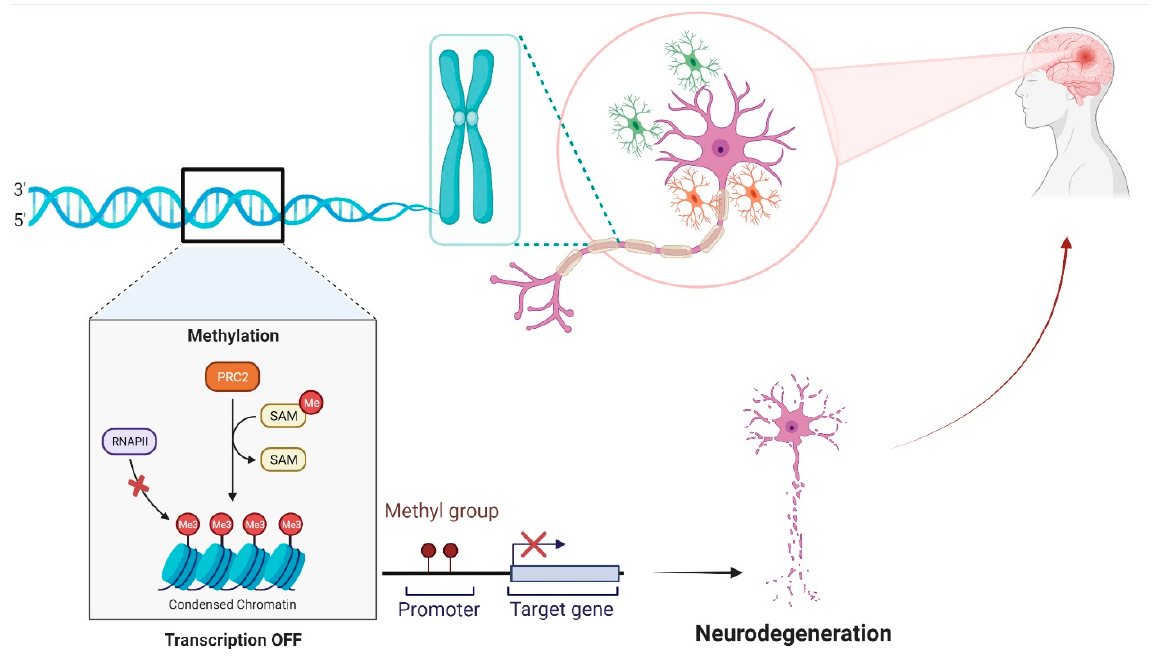
Figure 2. Schematic representation of DNA methylation causing the inhibition of target gene expression and progression towards neurodegeneration.